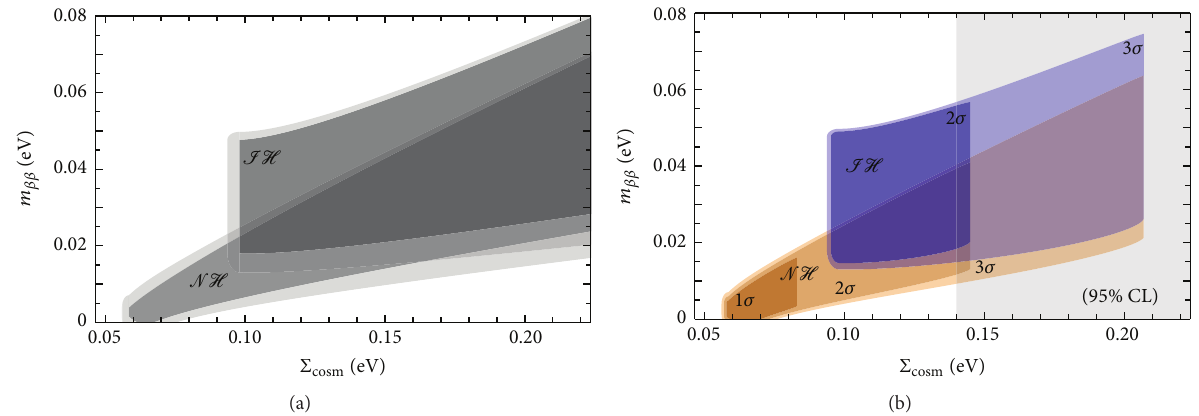
Figure 19: (a) Allowed regions for 𝑚 𝛽𝛽 as a function of Σ with constraints given by the oscillation parameters. The darker regions show the spread induced by Majorana phase variations, while the light shaded areas correspond to the 3𝜎 regions due to error propagation of the uncertainties on the oscillation parameters. (b) Constraints from cosmological surveys are added to those from oscillations. Different CL contours are shown for both hierarchies. Notice that the 1𝜎 region for the IH case is not present, being the scenario disfavored at this confidence level. The dashed band signifies the 95% CL excluded region coming from [136]. Figure from